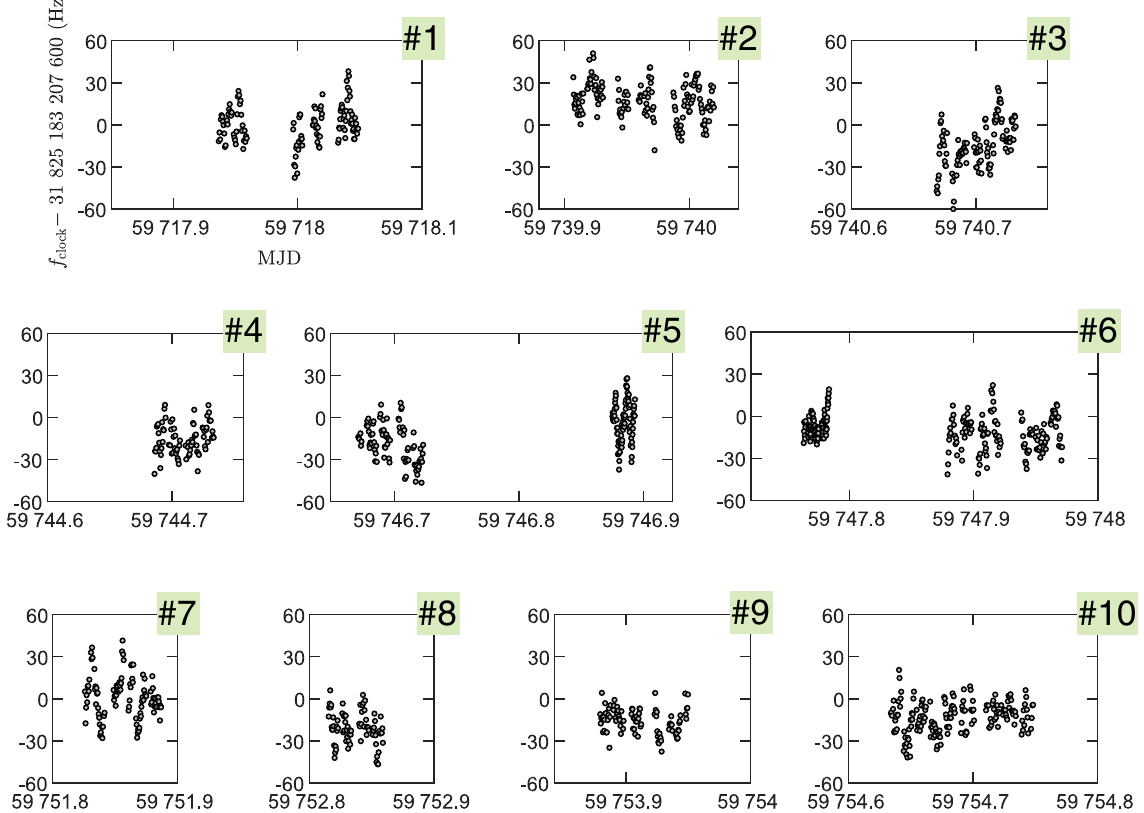
FIG. 8. Expanded dataset for the absolute clock frequency measurement. For experimental ease, the clock lasers and frequency comb are not actively steered toward the molecular resonance in real time. Instead, each measurement (filled gray circle) is derived from a single scan of the molecular clock transition under operational conditions, and the repetition rate of the frequency comb is counted with a zero dead-time frequency counter (1-s gate time). The shot-to-shot noise in the counted repetition rates is lowered by taking their average over a short window of time centered on the time stamp of the corresponding molecular clock measurement. The data are plotted against the time of measurement (Modified Julian Date, MJD). The frequency values are corrected for all systematic errors in Table I, the Rb clock calibration, and the gravitational redshift (Appendix F). Error bars are not shown for visual clarity. Trial numbers on the top right corner of each plot correspond to those in Fig. 5(a). The histogram of all measurements is shown in Fig. 5(b). The axes labels are displayed in the plot for trial 1 (top left), and are the same for the remaining